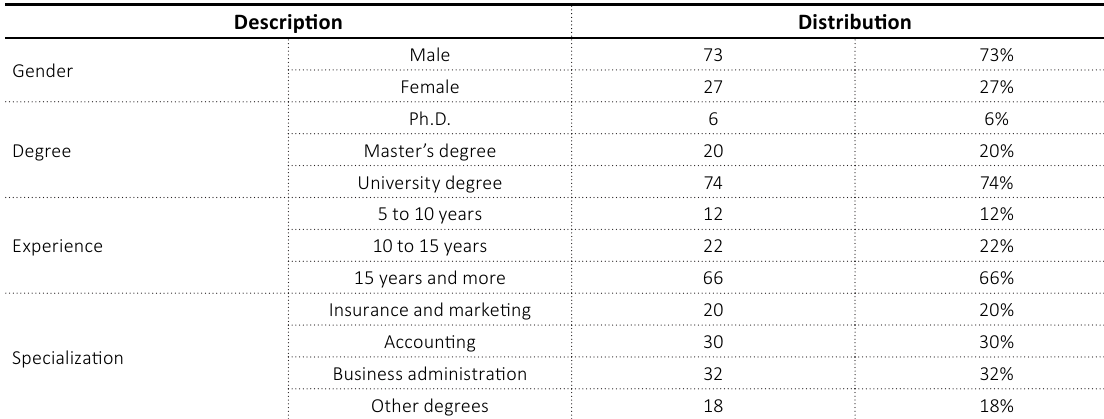
Table 2. The characteristics of the study